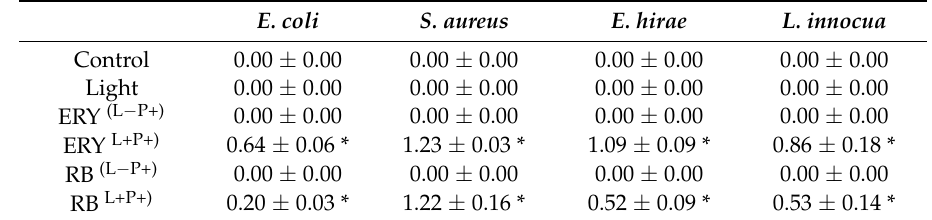
Table 3. Effect of photoinactivation mediated by RB and ERY on K + leakage (mg/L) of the bacteria